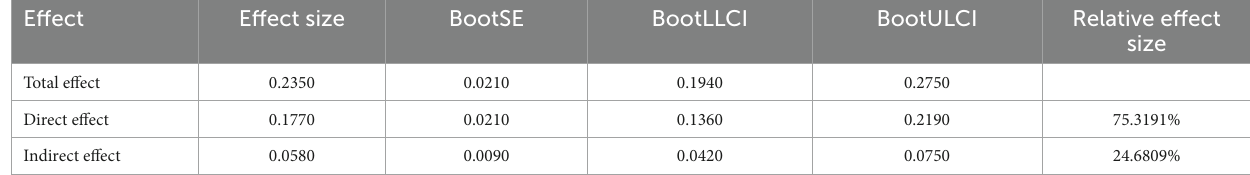
TABLE 4 Total effect, direct effect, and indirect effect among the